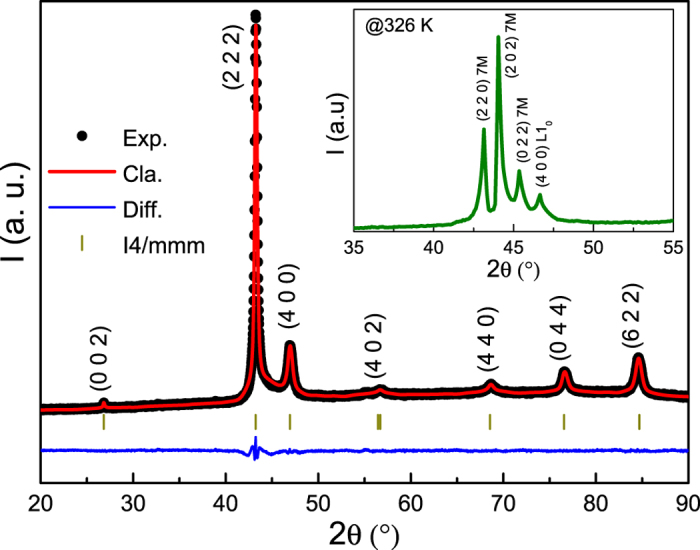
X-ray diffraction pattern for Ni55.8Mn18.1Ga26.1 alloy at room temperature.Inset: X-ray diffraction pattern at 326 K for this sample directly heated from room temperature.